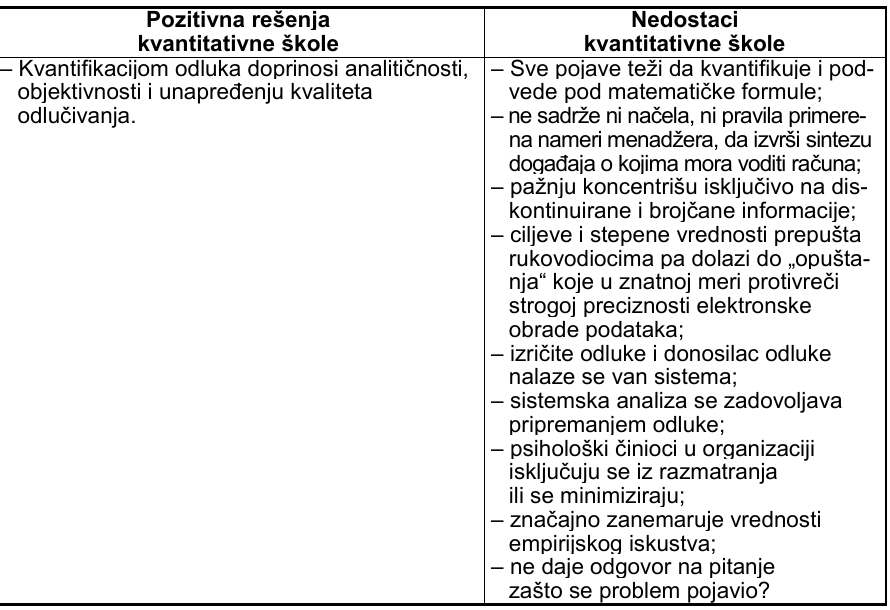
Nedostaci kvantitativne